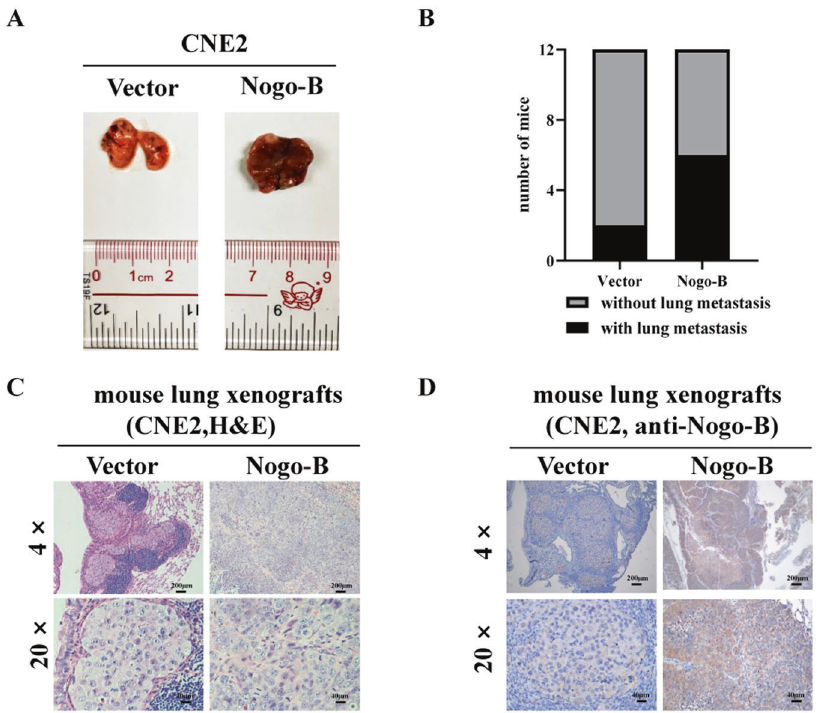
Fig. 3 Nogo-B promotes metastasis in vivo. A Image of the mouse lungs in each group, respectively. B The ratio of developing lung metastasis of nude mice was markedly higher in the Nogo-B group than that in the vector-control group. C H&E staining results con fi rmed the existence of lung xenografts, and the size of lung xenografts of the Nogo-B group were larger in the Nogo-B group. D Immunohistochemical results con fi rmed the high expression of Nogo-B in the Nogo-B groups.